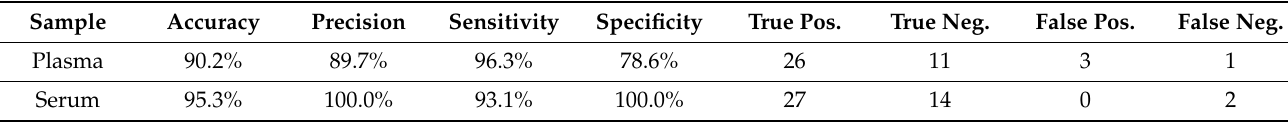
Table 4. PLSDA results on plasma and serum samples.